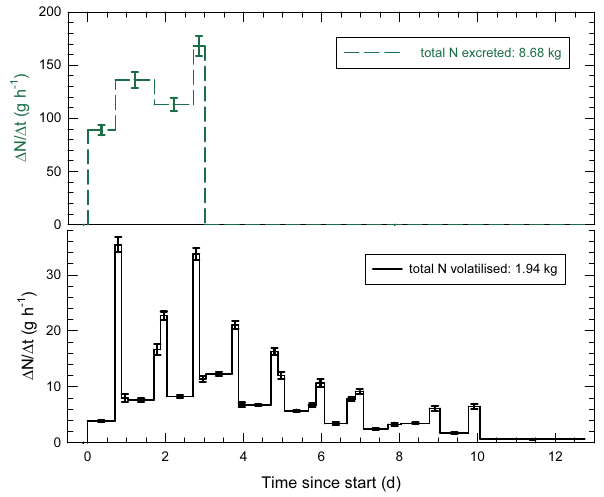
Fig. 2. Temporal evolution of N excretion rate of 12 cattle dur- ing their 3-day presence, estimated as the difference of N intake and N retained (top), and NH 3 -N volatilisation rate (bottom). Error bars for the latter represent estimated measurement uncertainty and are placed at the mid-times of the NH 3 collection periods, whose lengths are marked by the horizontally constant parts of the con- necting solid